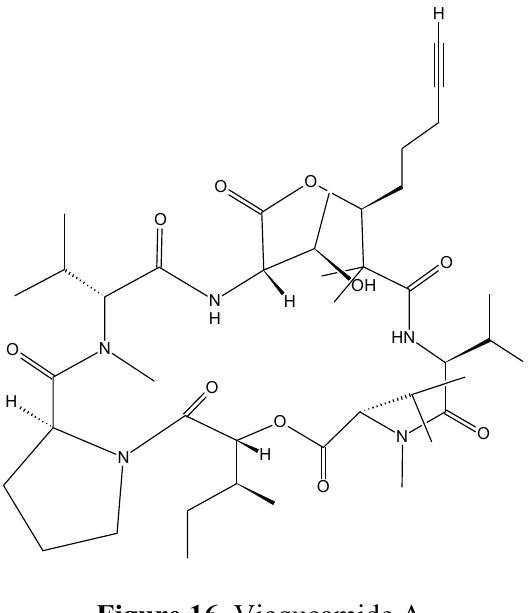
Figure 16. Viequeamide A.